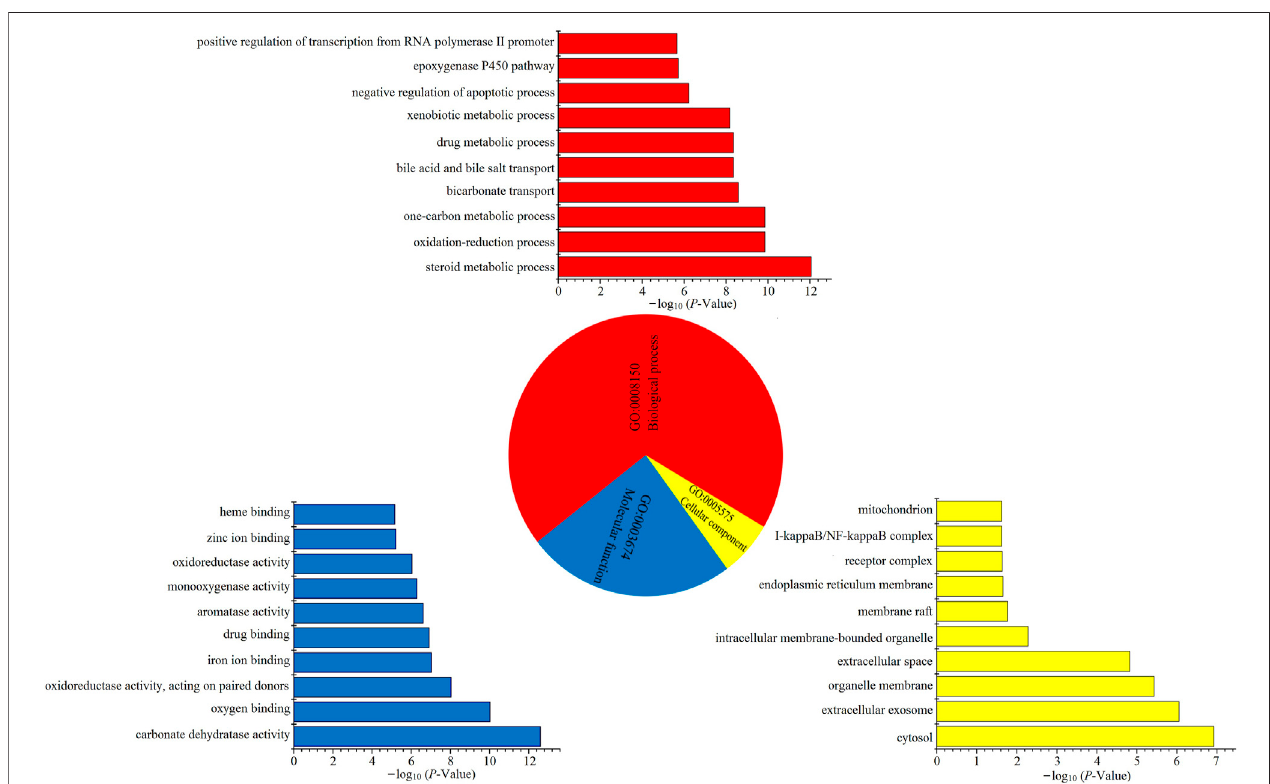
FIGURE 1 | GO enrichment analysis of the potential targets based on the active ingredients from